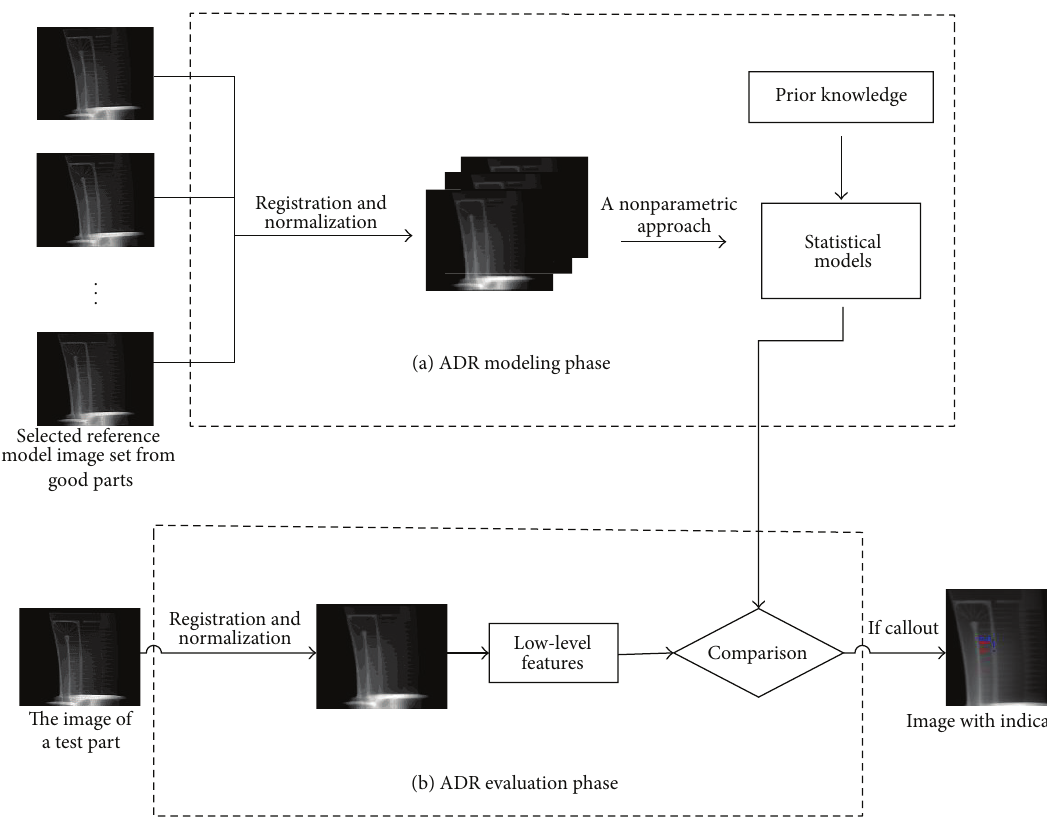
Figure 1: Diagram of ADR system defect recognition